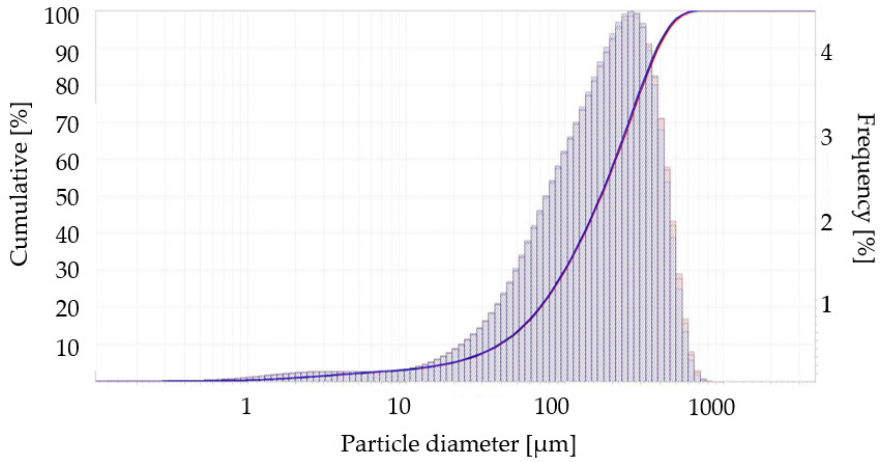
Figure 3. The frequency distribution and cumulative frequency of particle size distribution of sludge dust (measurement 3). Table 7. The average particle size distribution analysis in terms of cumulative frequency.